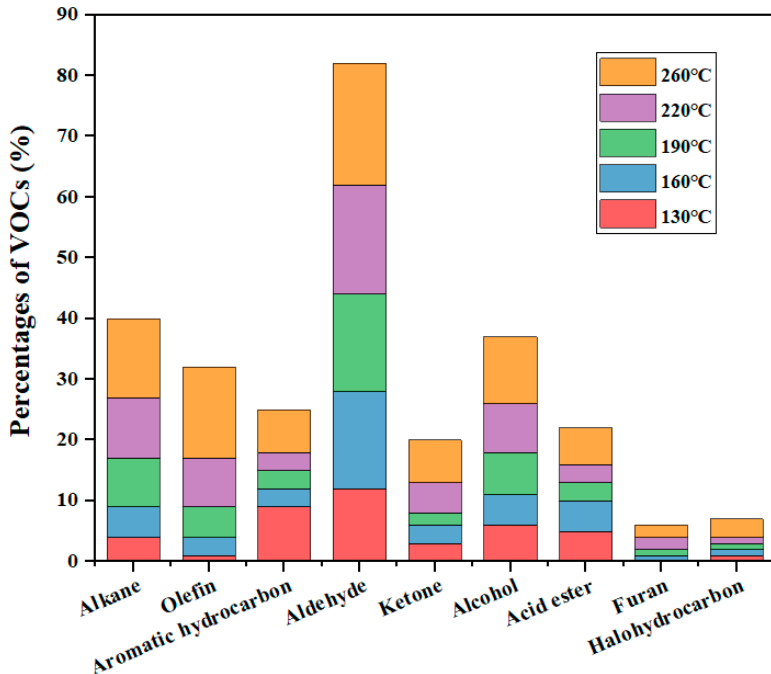
Figure 2. Distribution of VOCs in sunflower oil from 130 °C to 260 °C [34].